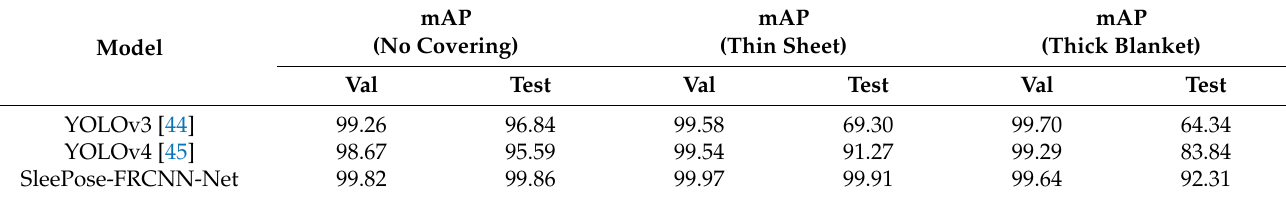
Table 7. Results of detection on the SLP